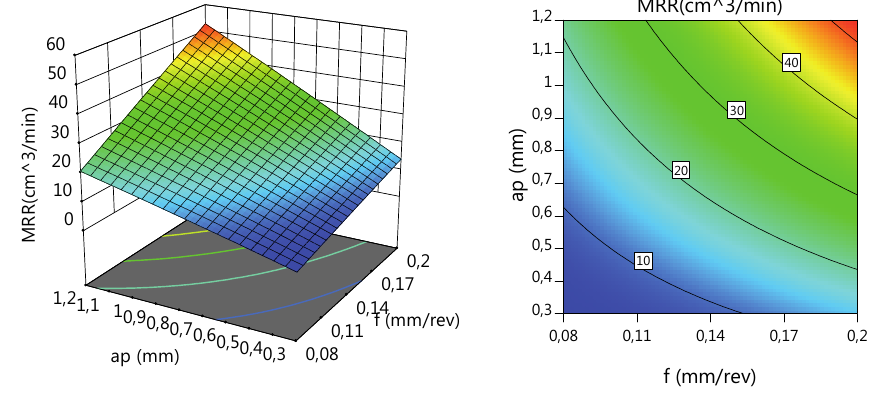
=245m/min c Effect of depth of cut and feed rate on material removal rate, with cutting speed V 25.